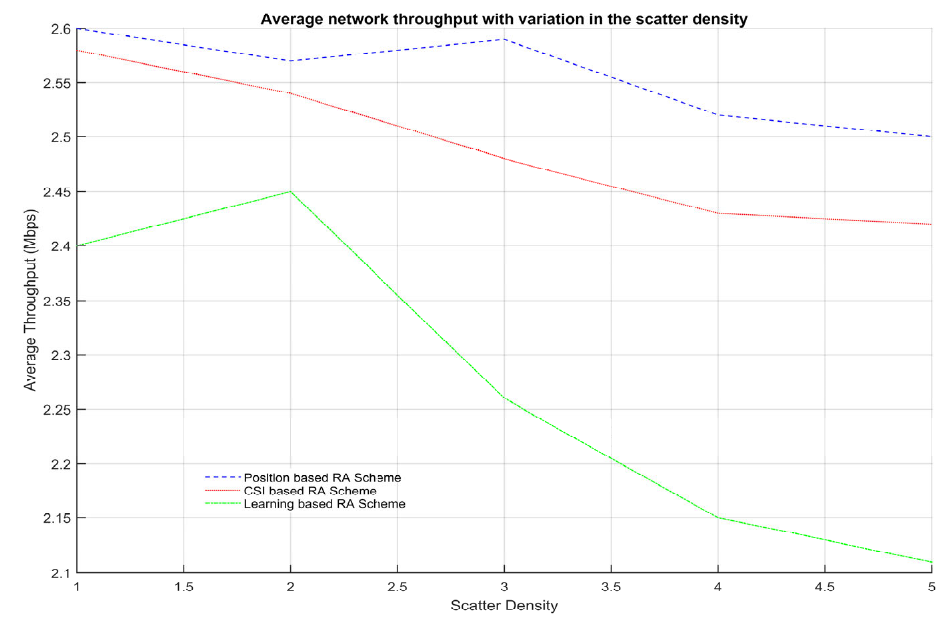
Figure 6. Average network throughput with variation in the scatter density.